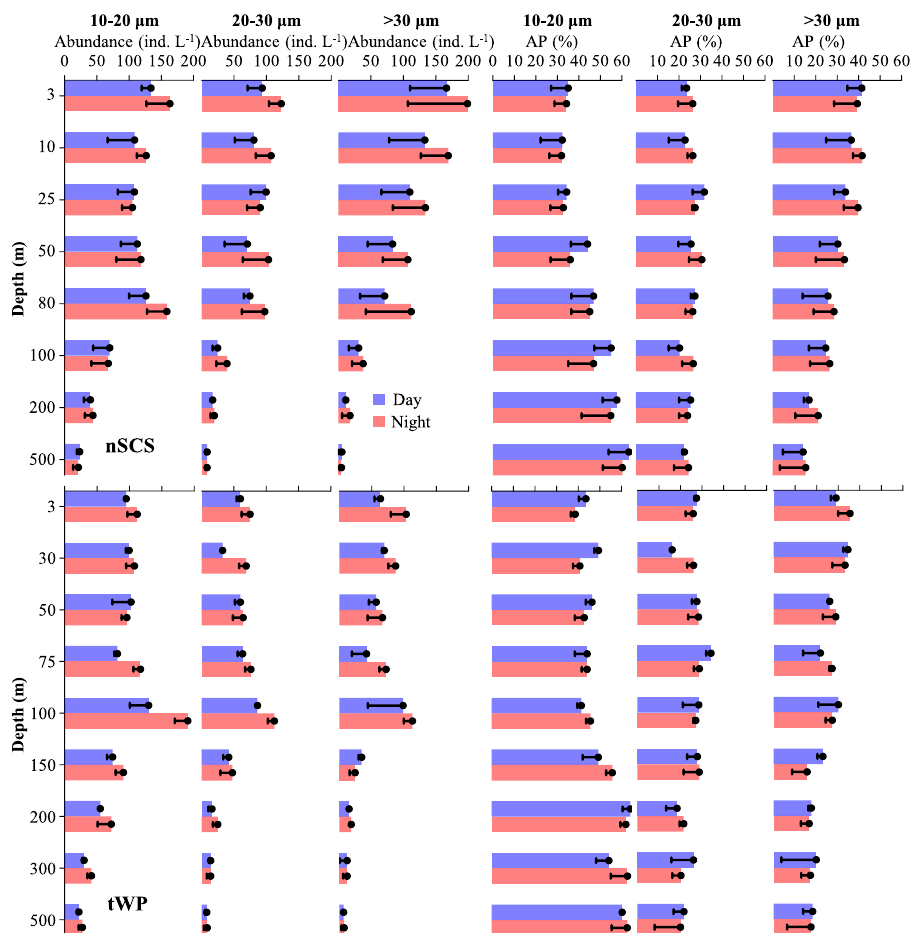
Figure 3. Diel variations of average abundance and abundance proportion (AP) of each aloricate ciliate size- fraction at each layers in the nSCS and